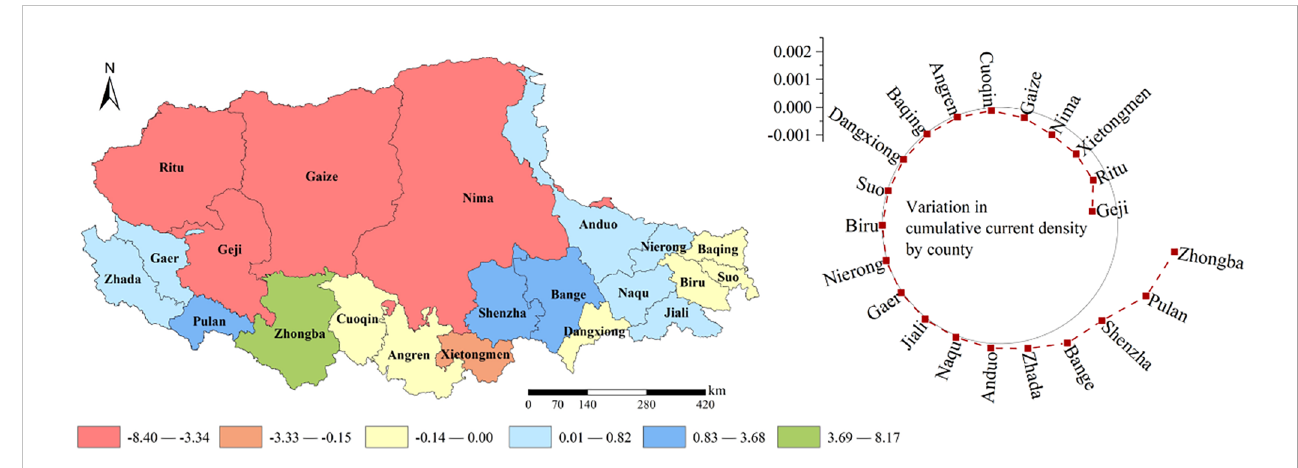
FIGURE 8 Variations of the cumulative current density in each county from 1990 to